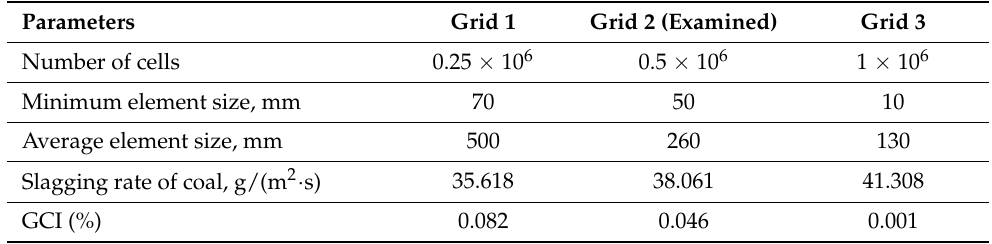
Table 7. Grid convergence